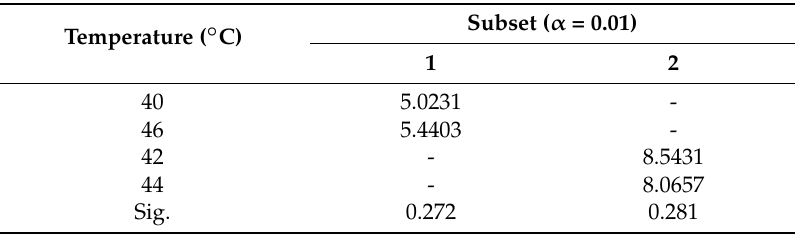
Table 4. Means comparison of unreduced pollen yield between any two different temperatures by Student Newman Keuls (S-N-K) comparison (significance level = 0.01).